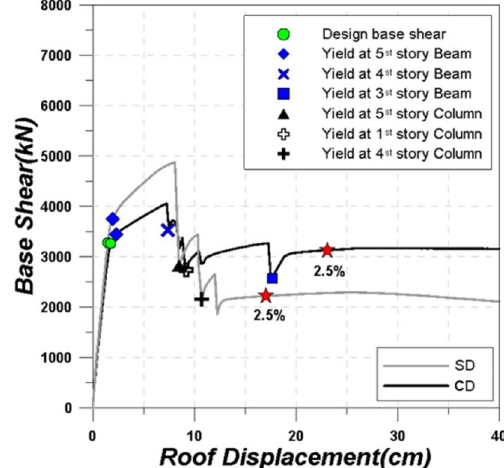
Fig. 14 Pushover curve of the performance-designed structure.